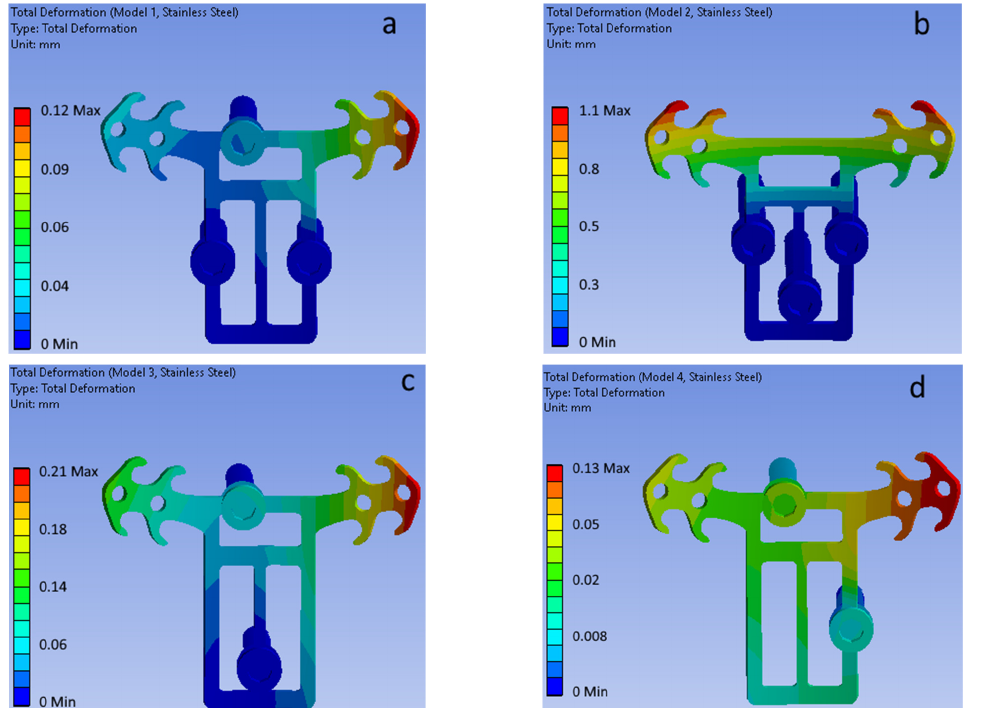
Figure 8. Total displacement fields for ( a )–( d ) mini-implant configurations (POD material—stainless steel). ( a ) Model 1. ( b ) Model 2. ( c ) Model 3. ( d ) Model 4. Figure 9 shows equivalent (von Mises) stress fields for each of the considered mini- implant configurations (POD is made of stainless steel).